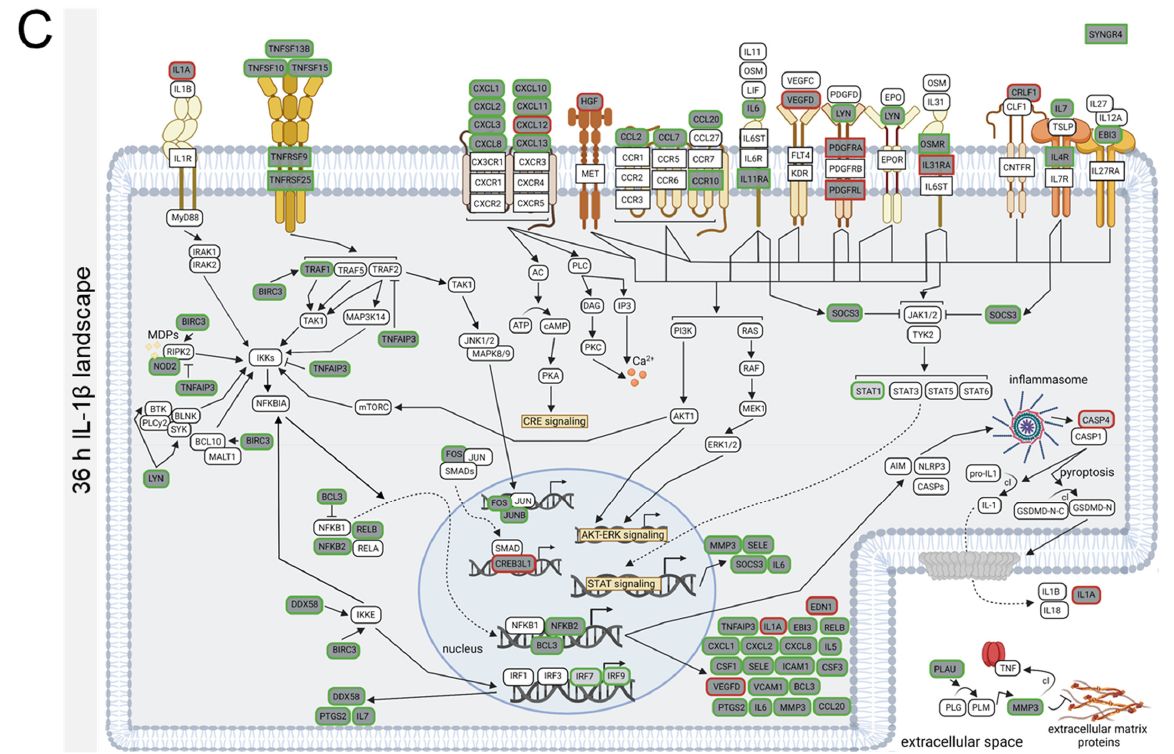
Figure 3. Molecular landscapes of the proteins encoded by the differentially expressed genes (DEGs) from the three core KEGG pathways (“Cytokine-cytokine receptor signaling”, “TNF signaling” and “NF κ B signaling”) following IL-1 β stimulation of human cortical spheroids for ( A ) 4 h, ( B ) 12 h and ( C ) 36 h. Protein functions and interactions were deduced based on information obtained from UniprotKB (https://www.uniprot.org/; accessed on 1 January 2022) and Genecards (https: //www.genecards.org; accessed on 15 January 2022). A detailed description of the protein-protein interactions occurring in these molecular landscapes can be found in Supplementary Information S6. Rectangularly framed protein: membrane-bound receptor; protein in green or red (rounded) rectangle frame: encoded by an up- or downregulated DEG, respectively; protein in dark-gray-filled (rounded) rectangle: encoded by a core KEGG pathway DEG; protein in light-gray-filled (rounded) rectangle: encoded by a DEG not in the core KEGG pathways; protein in white-filled (rounded) rectangle: not encoded by a DEG. Black arrows: stimulation or induction; inhibition arcs: inhibition; dotted arrows: translocation; fading arrows: enzymatic conversion; cl: